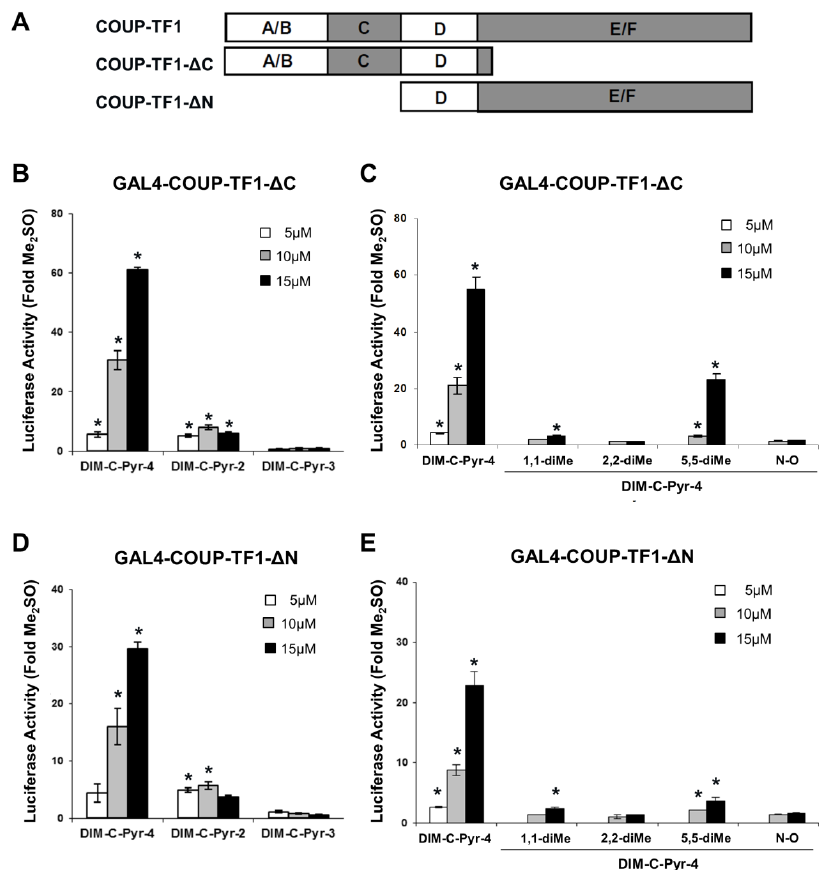
Figure 2. Activation of COUP-TFI domains by heteroaromatic C-DIMs. ( A ) Wild-type COUP-TFI and deletion variants. MCF-7 cells were transfected with GAL4-COUP-TFI- ΔC ( B , C ) or GAL4-COUP-TFI- ΔN ( D , E ) and GAL4-luc, treated with Me 2 SO or heteroaromatic C-DIMs, and luciferase activity determined as described in the Materials and Methods section. Results are expressed as means ± SE for three replicate determinations for each treatment group and significant ( p < 0.05) induction is indicated by an asterisk.